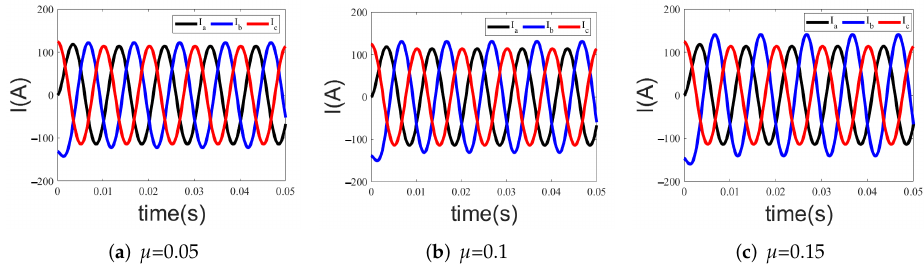
Figure 7. Three phase current when there is a B − phase fault. ( a ) µ = 0.05 ( b ) µ = 0.1 ( c ) µ = 0.15.